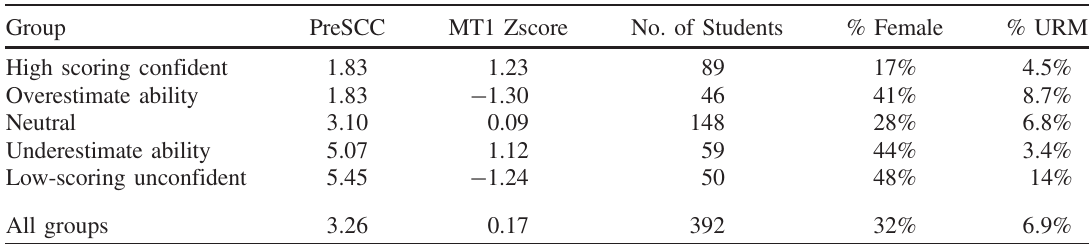
TABLE V. Initial-state group summary. Columns 2 and 3 are means for the group. Group